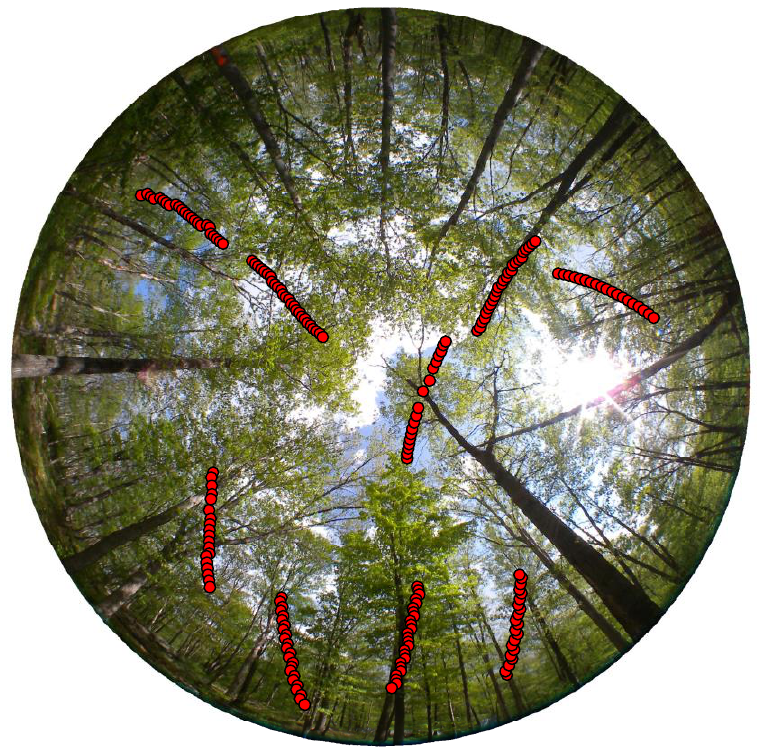
Figure 2. A hemispherical sky-oriented photo taken during the spring data collection at West Point, New York, with the global positioning system (GPS) satellite vehicle positions (red circles) plotted inside the image.